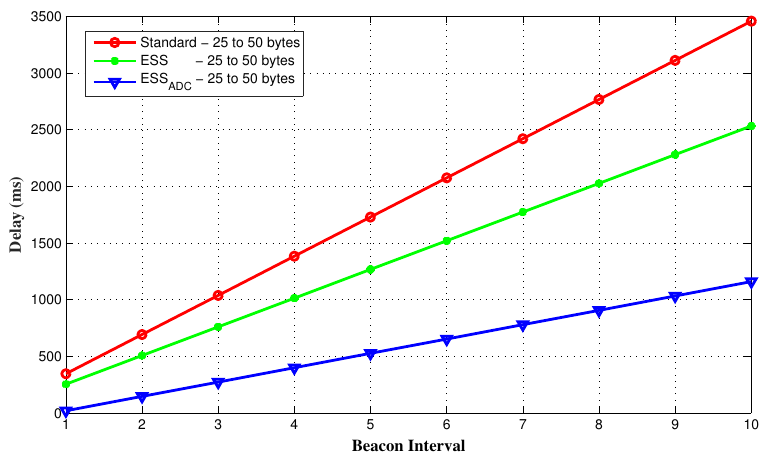
Figure 7. Accumulated delay for random data traffic.